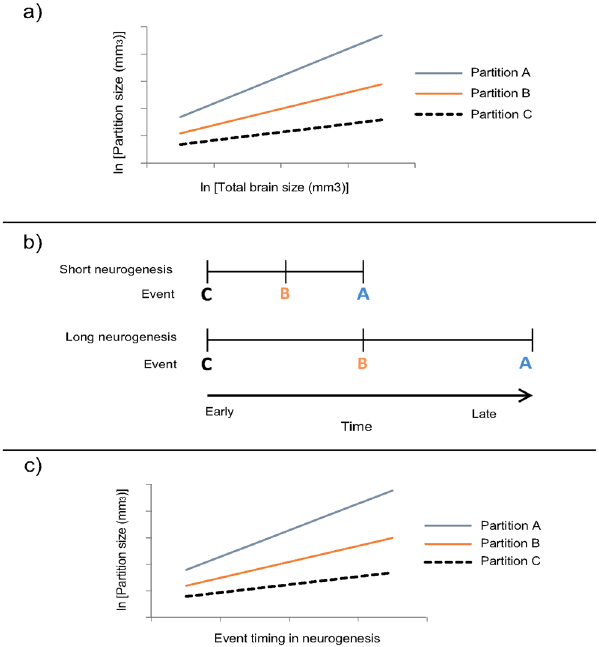
Figure 1. Schematic of the connection between partition scaling and neurogenesis in the evolution of brain proportions suggested by “late equals large”. Evolutionary partition scaling with brain size differs between A, B, and C ( a ), with steeper-scaling A and B also having longer and later-onset neurogenesis ( b ). “Late equals large” proposes that the neurogenetic timing directly predicts partition scaling ( c